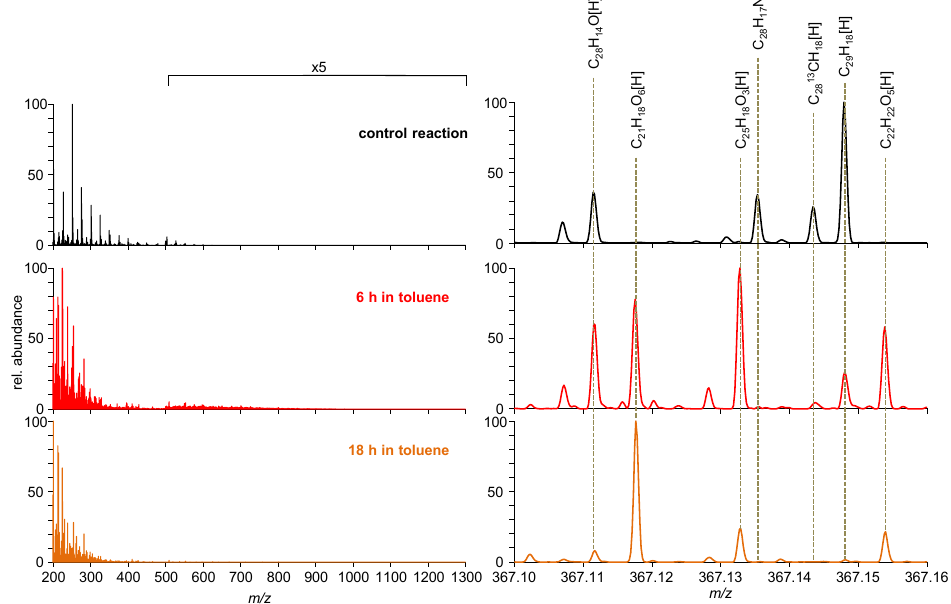
Figure 2. Mass spectra of organic phases from control reaction (black), ozonation within 6 h in toluene (red), within 18 h in toluene (orange), and corresponding zooms into m/z 367.10–367.16 (right).